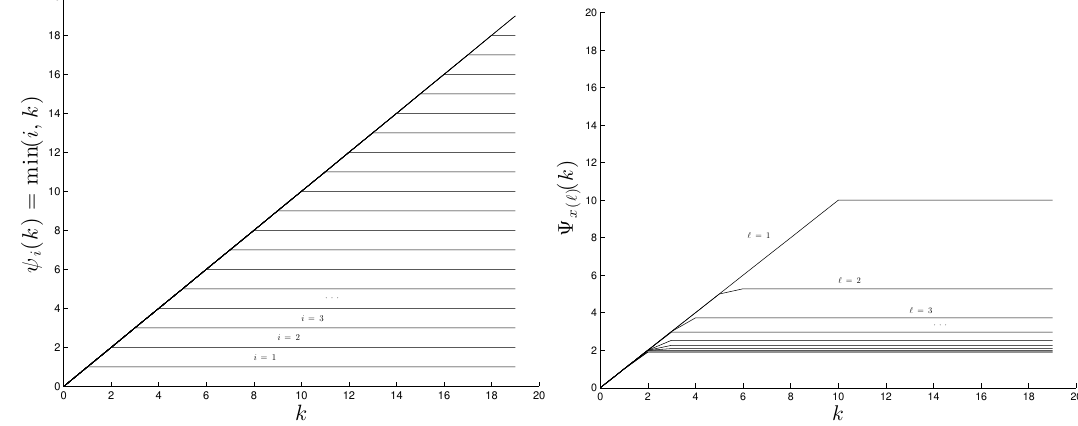
Figure 3: On the left, plots of ψ i ( k ) for i = 1, . . . , n . On the right, plots of Ψ x ( (cid:96) ) ( k ) for (cid:96) = 1, . . . , n /2 . In both plots n = 20